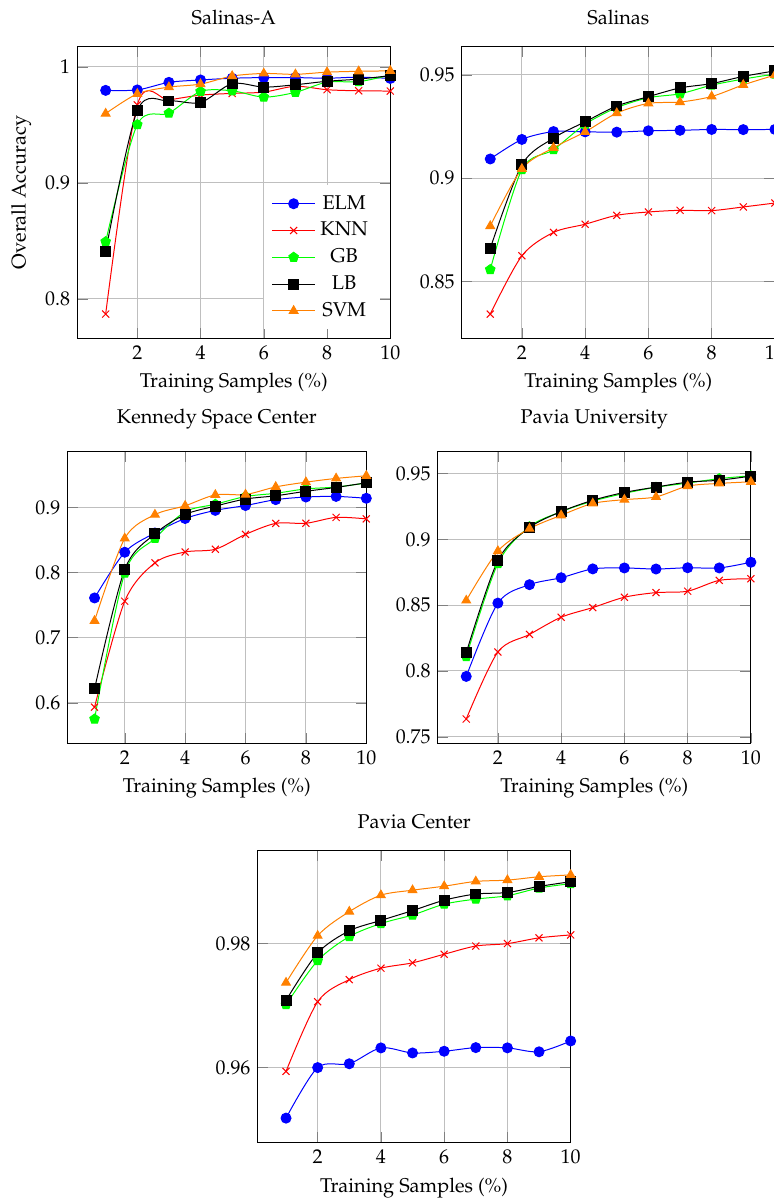
Figure 3. Overall accuracy with different number of training samples (%) selected in each iteration from different datasets. It is perceived from the above figure that by including the samples back to the training set, the classification results are significantly improved for all the classifiers. Moreover, it can be seen that SVM and ELM classifiers are more robust. For examples, with 2% actively selected samples in ELM classifier case, only 2% difference in the classification with a different number of samples can be observed, however, for the KNN and SVM classifiers, the difference is quite